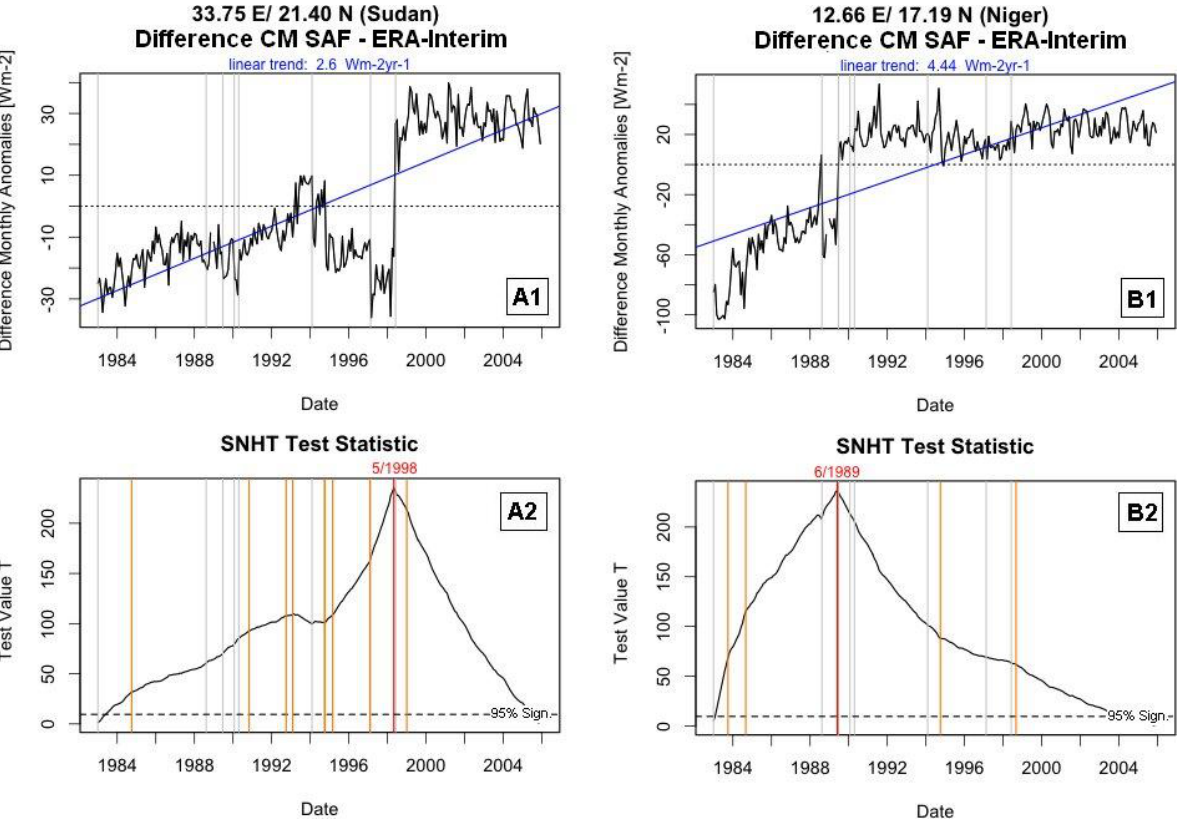
Figure 9. Relative SNHT analysis of CM SAF SIS versus ERA-Interim SIS series at two grid points with largest T values over Africa: ( A1, B1 ) time series; ( A2, B2 ) corresponding 0 SNHT test statistics. Satellite changes are indicated by grey lines and breaks by red (first analysis step) and orange (detected subsequently)